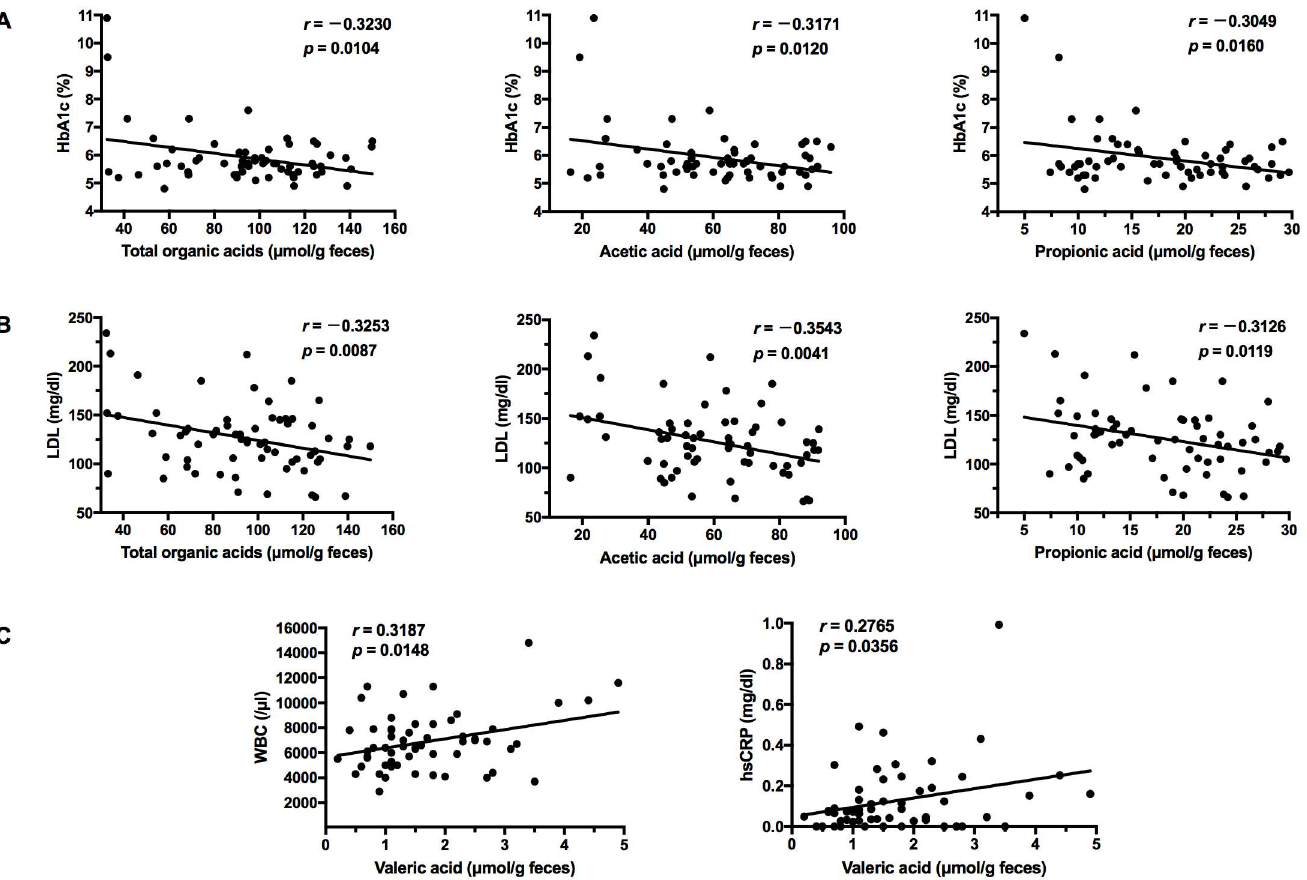
Fig 1. Scatter diagrams of organic acid concentrations and metabolic/inflammatory markers. Correlations betweenorganic acid concentrations and (A) glycatedhemoglobin A1c (HbA1c) and (B) low-density lipoprotein(LDL), and (C) betweenwhite blood cell counts (WBC) and high sensitivity C- reactive protein (hsCRP) levels were analyzedusing